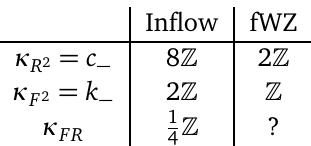
Table 1: Quantization of anomaly coefficients predicted by inflow of classical Chern- Simons actions versus the finite Wess-Zumino consistency condition